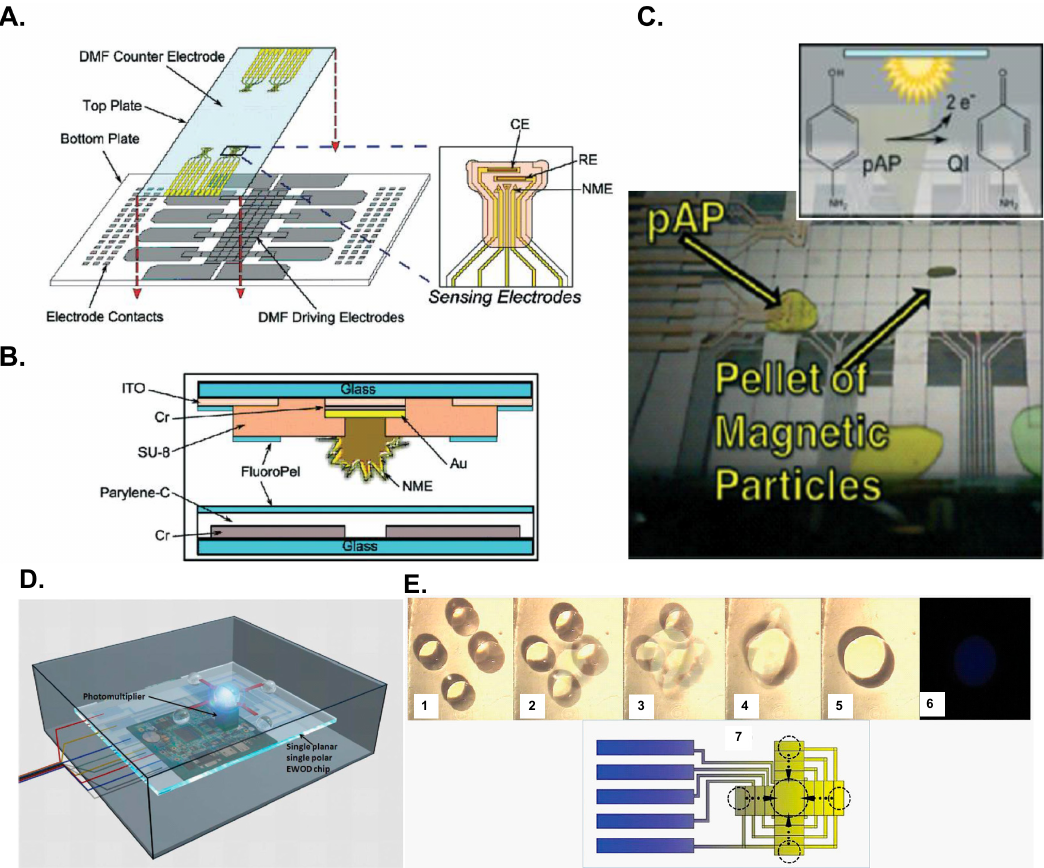
Figure 6. DMF further integrated another platform to perform immunoassays as described in: ( A – C ) Rackus et al. [36]; ( D , E ) Zeng et al. [62]. ( A ) DMF device with integrated nanostructured microelectrodes; ( B ) Schematic of a cross section of a DMF device; ( C ) Electrochemical measurements of the DMF device; (D). Schematic of the DMF chemiluminescent detector; ( E ) Mixing process on the